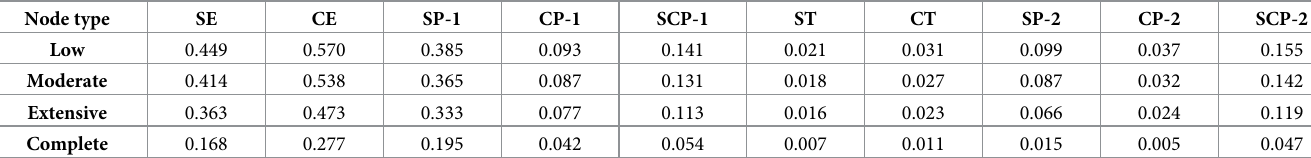
Table 3. Probability of low, moderate, extensive, and complete damage to various pipe components (PGA = 0.2 g ). Node type